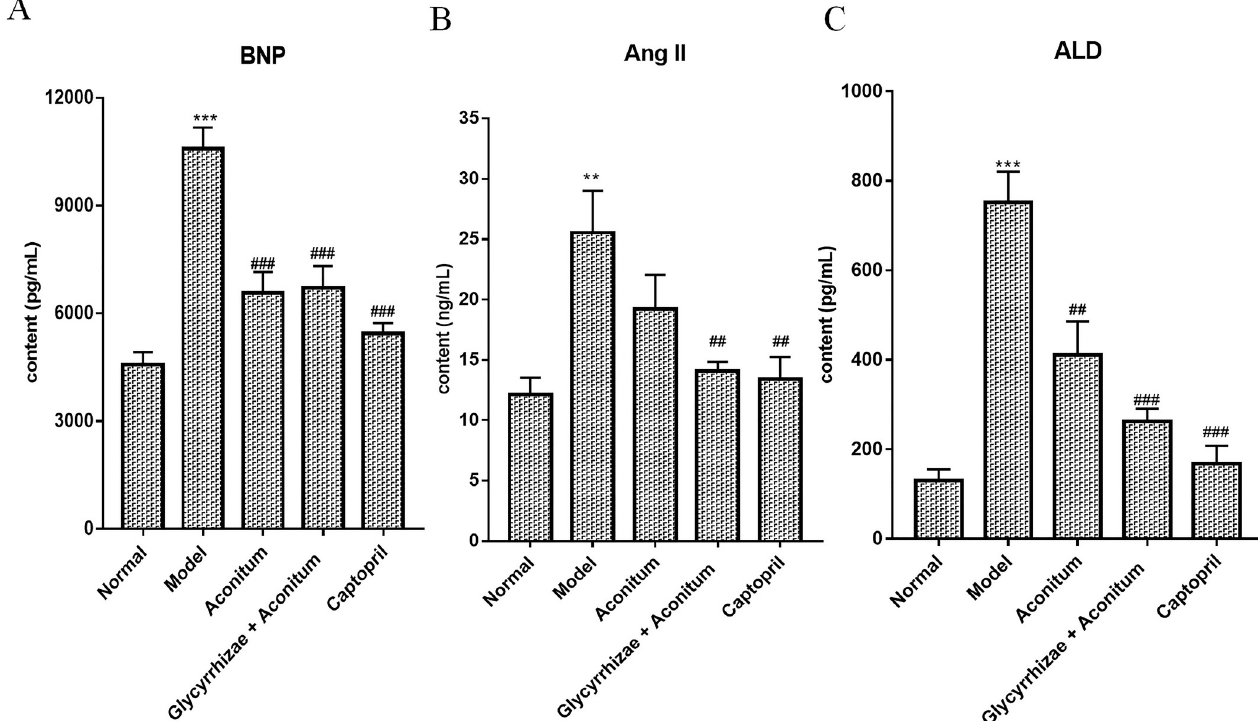
Fig 7. The intervention effect of Aconitum and the compatibility of Glycyrrhizae and Aconitum on serum BNP, ang II and ALD levels. The rat model of CHF was established by intraperitoneal injection of ADR (2.5 mg / kg). The rats were randomly divided into model group, Aconitum (0.3 g / mL) group, Glycyrrhizae with Aconitum (0.6 g / mL) group and Captopril (1.25 mg / mL) group. Each treatment group was given 5 mL / kg / D by gavage for 4 weeks, the normal group and model group were given the same volume of distilled water by gavage. (A) The levels of BNP in serum determined by ELISA. (B) The levels of Ang II in serum determined by ELISA. (C) The levels of ALD in serum determined by ELISA. Compared with the normal group, �� P < 0.01; ��� P < 0.001; Compared with the model group, ##P < 0.01; ###P < 0.001; Compared with Aconitum group, $ P < 0.05; $$ P < 0.01. https://doi.org/10.1371/journal.pone.0270069.g007 PLOS ONE | https://doi.org/10.1371/journal.pone.0270069 June 27,